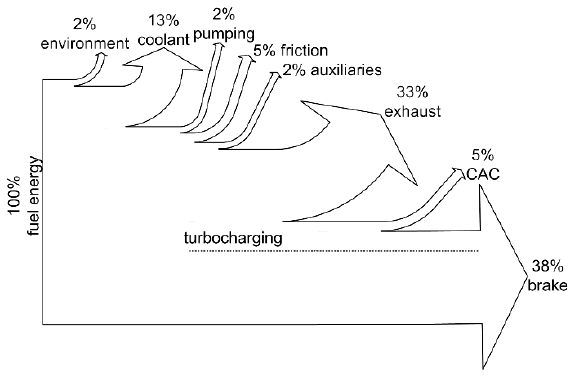
Figure 3. Sankey diagram of conventional ICE [20].